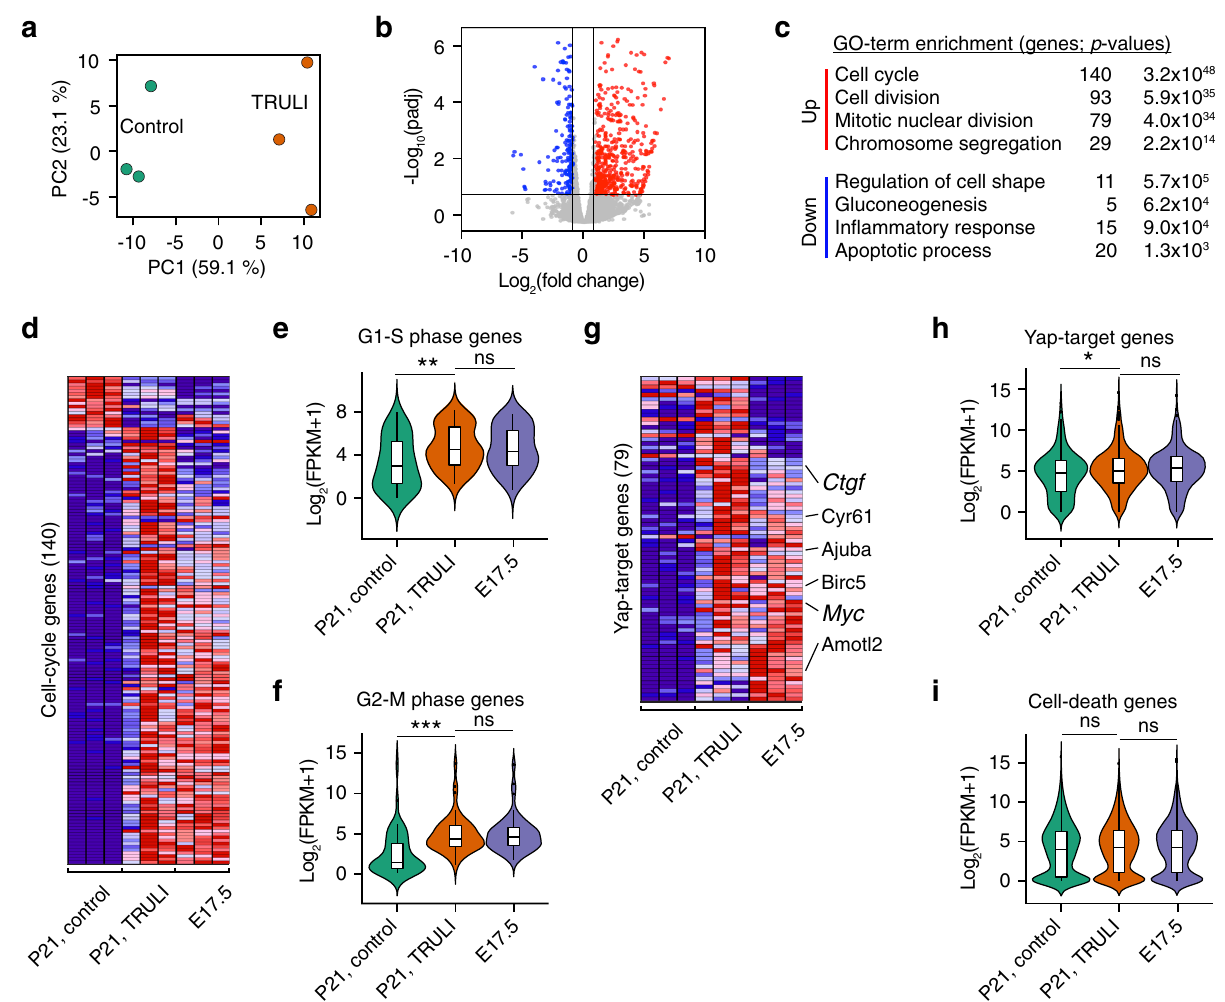
Fig. 4 Gene-expression changes evoked by TRULI treatment in utricular supporting cells. a For three experiments, principal-component analysis was performed on RNA-sequencing data obtained from utricular supporting cells after 5 days of treatment with TRULI or from control samples. The RNA-seq data are available through GEO (GSE148528). b A volcano plot visualizes the differentially expressed genes (|log 2 (fold change) | > 1; padj < 0.05). Genes upregulated after TRULI treatment compared to control are labeled in red and those downregulated in blue. c Gene-ontology (GO) analysis performed with DAVID software demonstrates that the terms associated with the cell cycle are the most enriched in the genes upregulated by TRULI, whereas the terms associated with stress are more enriched in the control gene set. A full list of differentially expressed genes identi fi ed using DEseq2 is available on request. d For three experiments, a heatmap demonstrates the relative expression levels of 140 cell-cycle genes differentially expressed between control and TRULI-treated supporting cells (false discovery rate < 0.01) in comparison to E17.5. Highly expressed genes are shown in red and genes with relatively low levels of expression are depicted in blue. e Cell-cycle genes characteristic of the S phase are signi fi cantly upregulated by TRULI ( p = 0.00349 by a two- sided Wilcoxon rank-sum test with continuity correction, n = 42 genes for each condition) to the levels found in E17.5 supporting cells ( p = 0.7781 by a two-sided Wilcoxon rank sum test with continuity correction, n = 42 genes for each condition). Box plots indicate median (middle line), 25th, 75th percentile (box) and 5th and 95th percentile (whiskers) as well as outliers (single points). f Markers of the G2-M transition are likewise upregulated ( p = 3.892 × 10 − 7 by a two-sided Wilcoxon rank sum test with continuity correction, n = 52 genes for each condition) to the levels found in E17.5 supporting cells ( p = 0.9508 by a two-sided Wilcoxon rank sum test with continuity correction, n = 42 genes for each condition). Box plots indicate median (middle line), 25th, 75th percentile (box) and 5th and 95th percentile (whiskers) as well as outliers (single points). g For three experiments, the heatmap demonstrates the relative expression levels of 79 Yap-target genes differentially expressed between control and TRULI-treated supporting cells (false discovery rate < 0.01) in comparison to E17.5 embryonic levels. h The expression of Yap-target genes is upregulated in response to TRULI ( p = 0.01807 by a two-sided Wilcoxon rank sum test with continuity correction, n = 342 genes for each condition) to the levels found in E17.5 supporting cells ( p = 0.3431 by a two-sided Wilcoxon rank sum test with continuity correction, n = 42 genes for each condition). Box plots indicate median (middle line), 25th, 75th percentile (box) and 5th and 95th percentile (whiskers) as well as outliers (single points). i In contrast, the relative level of expression for genes associated with cell death remains unchanged between controls, TRULI-treated ( p = 0.06373 by a two-sided Wilcoxon rank sum test with continuity correction, n = 2031 genes for each condition) and E17.5 supporting cells ( p = 0.6954 by a two-sided Wilcoxon rank sum test with continuity correction, n = 2031 genes for each condition). Box plots indicate median (middle line), 25th, 75th percentile (box) and 5th and 95th percentile (whiskers) as well as outliers (single points). See also Supplementary Fig.